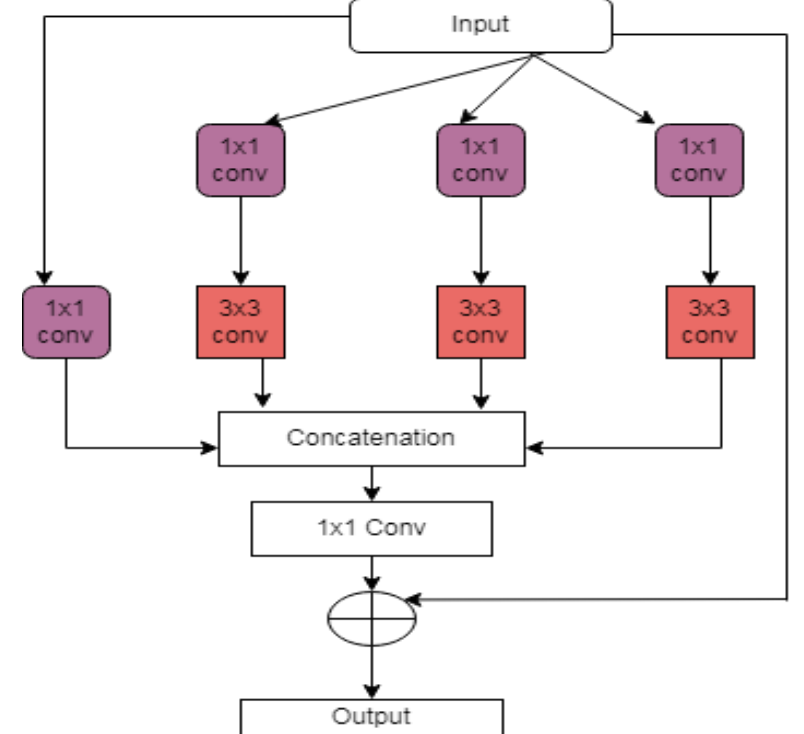
Figure 7. Residual inception block.